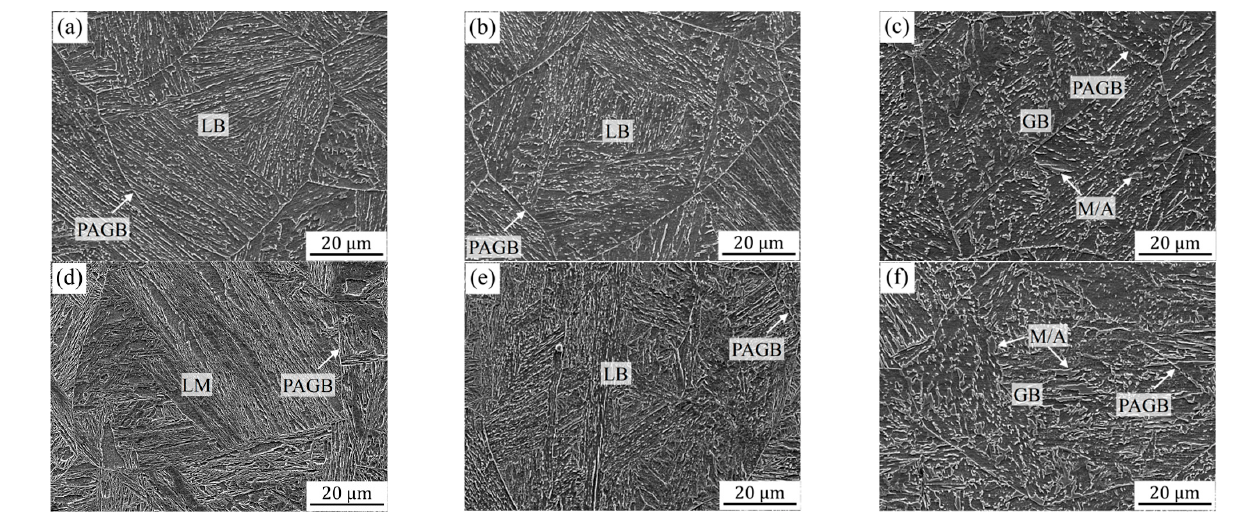
Figure 3. SEM images showing the microstructure of the simulated samples with 0.04 wt.% C ( a – c ) and 0.12 wt.% C ( d – f ) under the different heat inputs: ( a , d ) 10 kJ/cm, ( b , e ) 20 kJ/cm and ( e , f ) 50 kJ/cm. (PAGB: prior austenite grain boundary).